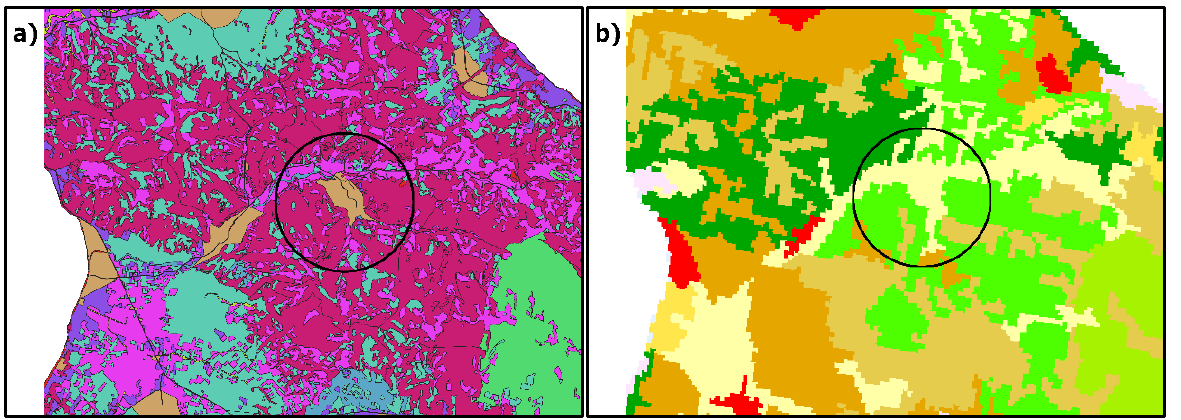
Figure 4. Black circle indicates the village of Kassandrino that has been captured in ( a ) the Kassandra dataset, ( b ) but it is absent in CLC dataset.